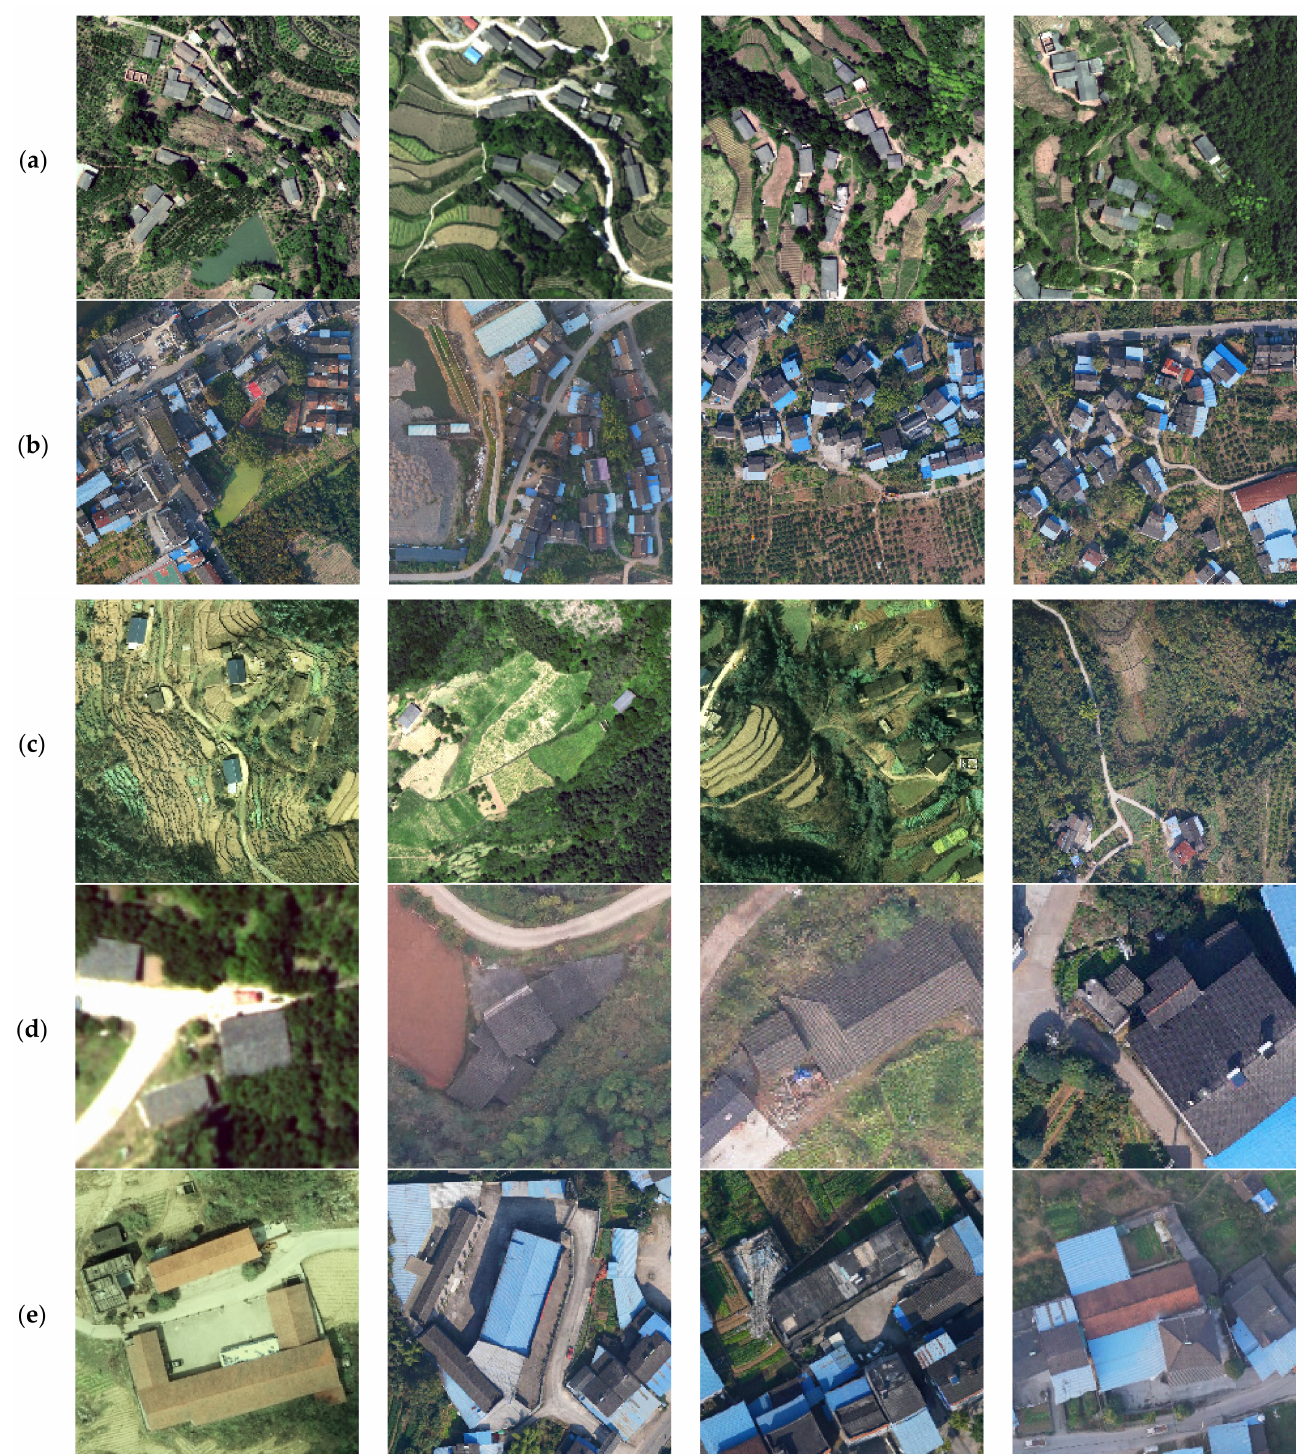
Figure 2. Different rural building targets in the dataset: ( a ) mountain dense rural buildings; ( b ) suburb dense rural buildings; ( c ) sparse rural buildings; ( d ) small rural buildings; ( e ) large rural